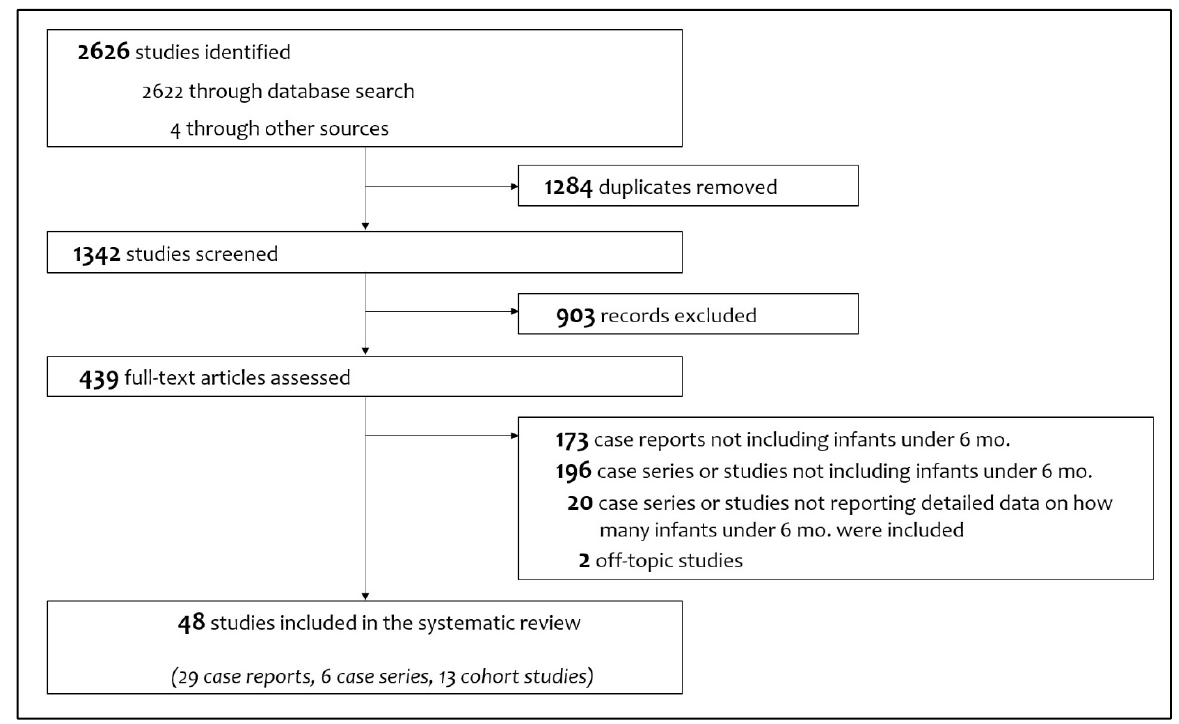
Figure 2. Flowchart of study selection process. Table 1. Characteristics of articles included in the systematic review. Methodological quality of case description was assessed only for case report and case series, or cohort studies which provided supplemental data with case descriptions.